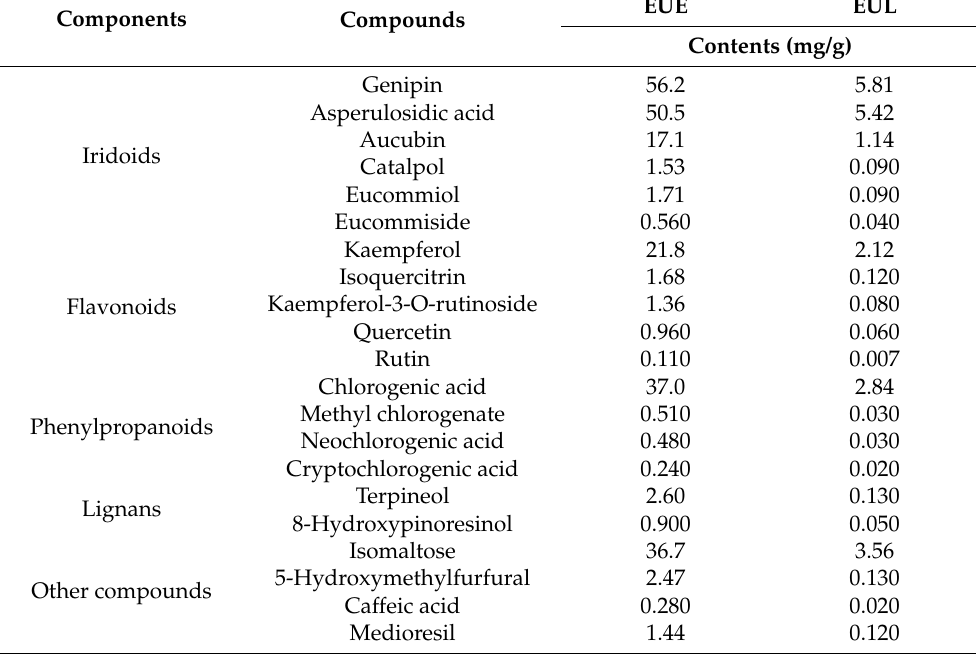
Table 3. Components and contents of EUE and EUL.